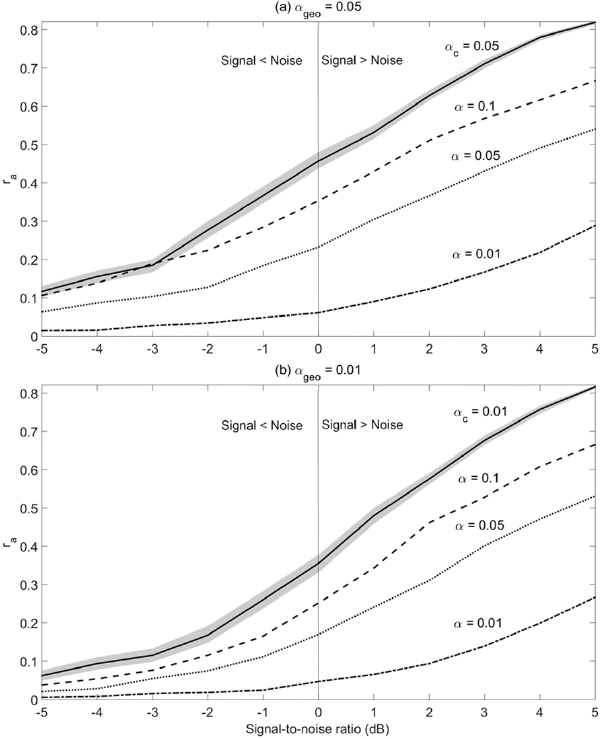
Figure 11. (a) The ensemble mean r a as a function of the signal- to-noise to ratio for the areawise test with α c = 0 . 05 and the ge- ometric test with α geo = 0 . 05. Gray shading represents the 95% confidence interval and all means for the geometric test are signifi- cantly different at the 5% level from the means for the areawise test except for those corresponding to the α = 0 . 01 curve for signal-to- noise ratios less than − 1.5. The confidence intervals and statistical significance were obtained by the bootstrap method (Efron, 1979). The data for each signal-to-noise-ratio were sampled with replace- ment 1000 times to generate a distribution of bootstrap replicates, from which 95% confidence intervals were obtained. Two ensem- ble means were said to significantly different at the 5% level if their 95% confidence intervals did not intersect. (b) Same as (a) except with α c = 0 . 01 and α geo = 0 . 01. All means for the geometric test in panel (b) are significantly different at the 5% level from the means for the areawise